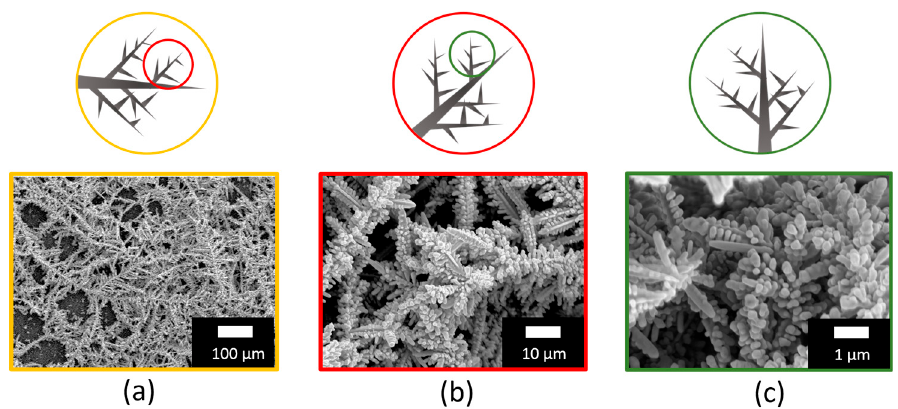
Figure 2. Fractal Ag dendrites: Schematic and plan view scanning electron microscopies of Ag dendrites acquired at three di ff erent magnification scales of ( a – c ) in order to test the scale invariance of the